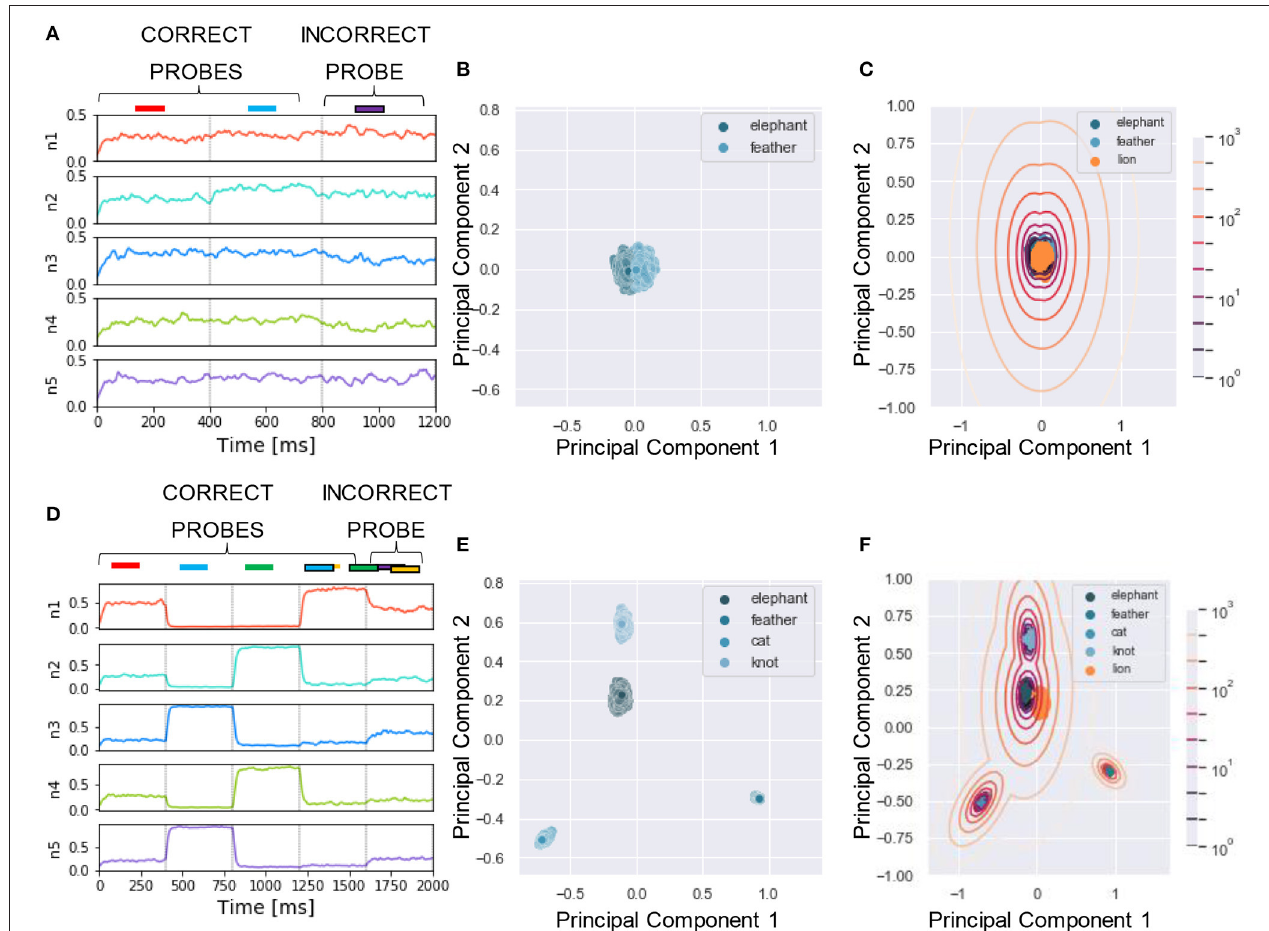
FIGURE 10 | Experiment 5—output dynamics and clustering. (A–C) refer to the results of Experiment 5 on real-world images with a single mixture presented during training. (D–F) refer to the results of Experiment 5 on real-world images with three mixtures presented during training. (A) Voltage dynamics of the 5 output neurons during inference, when the two training images and one unseen image are tested. As expected, the neuron population is not able to respond with different dynamics to the three images, and the voltage of all the output neurons fluctuates randomly throughout the whole testing sequence. (B) The PCA projection of the datapoints belonging to the two seen images (in blue) shows that the clusters are collapsed into a single cluster. (C) When GMM is applied, all the datapoints representing both the targets (in blue) and the unseen image (in orange) fall within the same regions, making it impossible to distinguish the different images based on the population dynamics. (D) Voltage dynamics of the 5 output neurons during inference, when the four targets and one unseen image are tested. As expected, the neuron population has learnt the features of the different images and responds with different dynamics to the five images. Each output neuron has an enhanced response to one or few inputs. (E) The PCA projection of the datapoints belonging to the four learnt images (in blue) shows that the clusters are compact and spatially distant one from the other. (F) When GMM is applied, the model shows that the network clearly distinguished the target and distractors (in blue) from the unseen image (in orange). These results suggest that humans would be able to distinguish single visual targets if previously seen in different